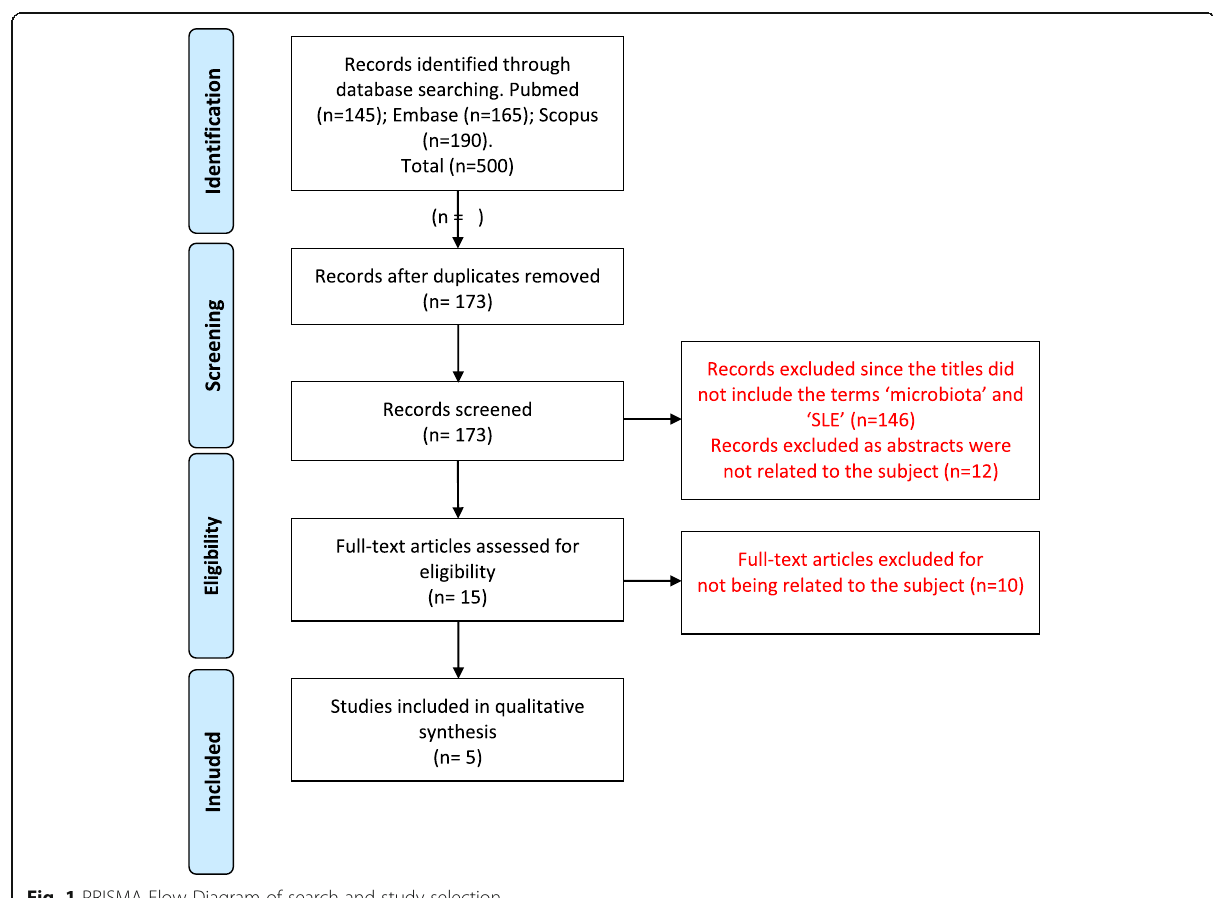
Fig. 1 PRISMA Flow Diagram of search and study selection